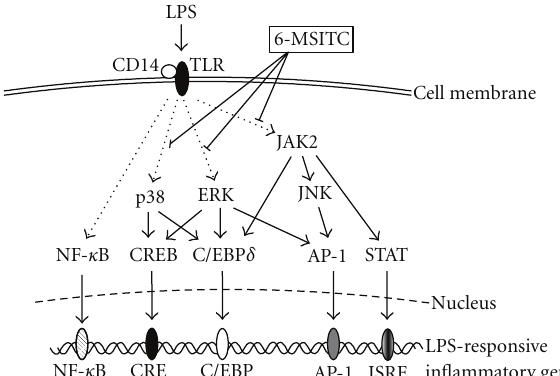
Figure 2: Schematic molecular model of 6-MSITC on the suppres- sion of LPS-induced inflammatory